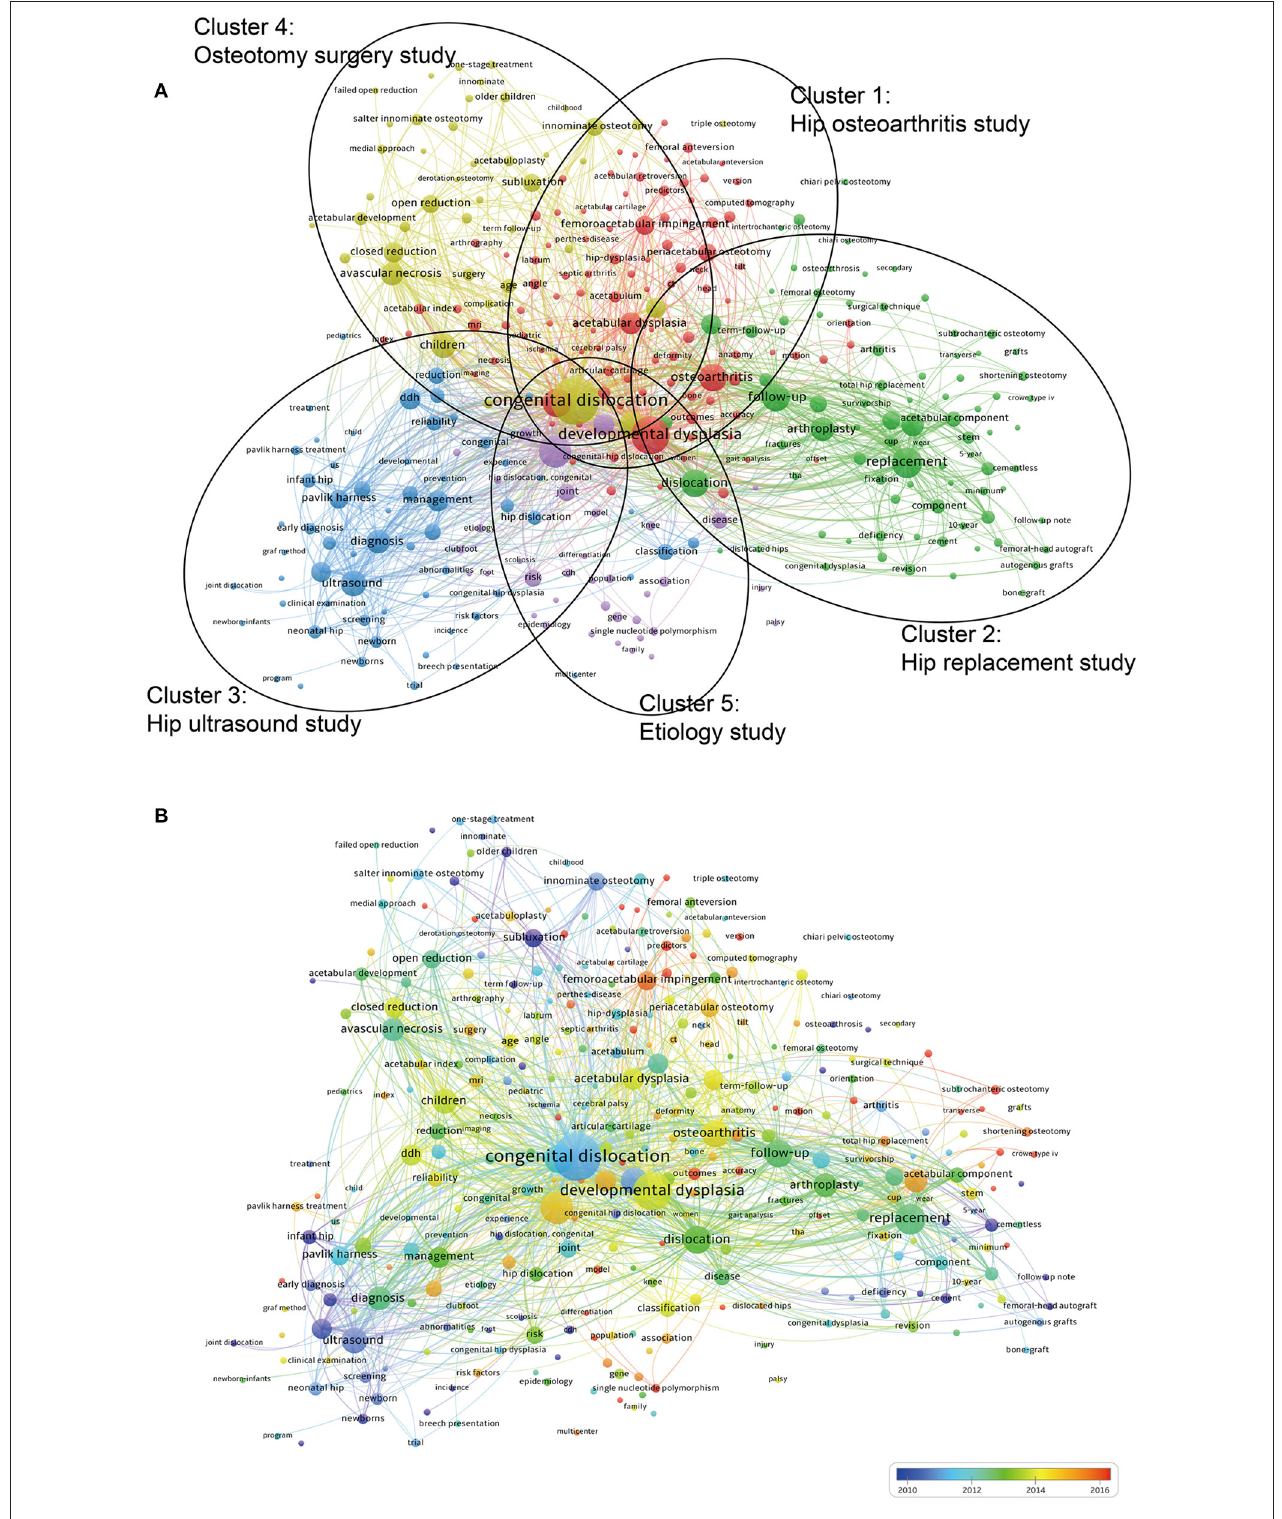
FIGURE 8 | Keyword analysis of research hotspots. Network visualization (A) and the overlay visualization map (B) of the keywords co-occurrence analysis using VOSviewer.